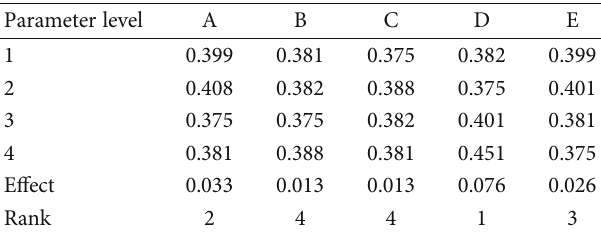
Figure 6: Numerical simulation of the distribution of warpage of the thin-walled part for the L Table 4: Numerical simulation of the signal-to-noise (S/N) ratio reaction of warpage of the thin-walled